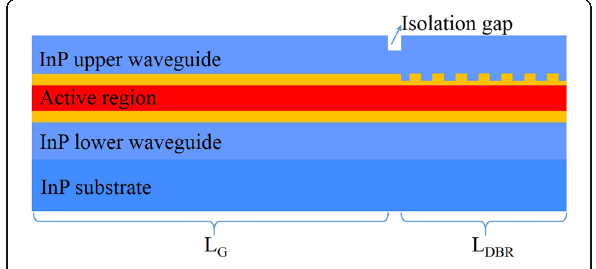
Fig. 1 Scheme of a DBR QCL consisting of a gain section L G , a DBR section L DBR and a current isolation